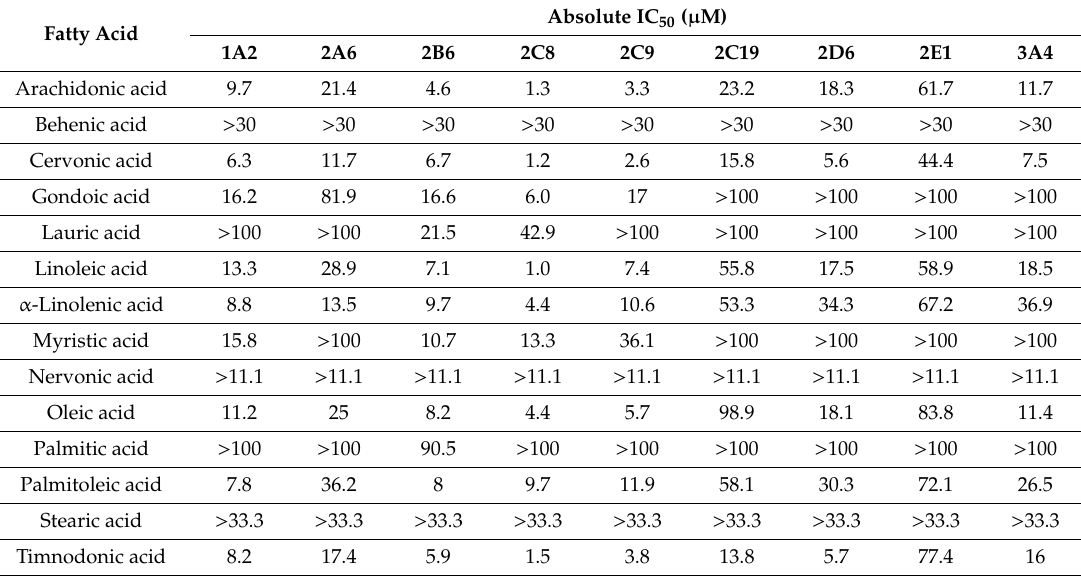
Table 5. E ff ect of fatty acids on nine CYPs: 1A2, 2A6, 2B6, 2C8, 2C9, 2C19, 2E1 and 3A4.